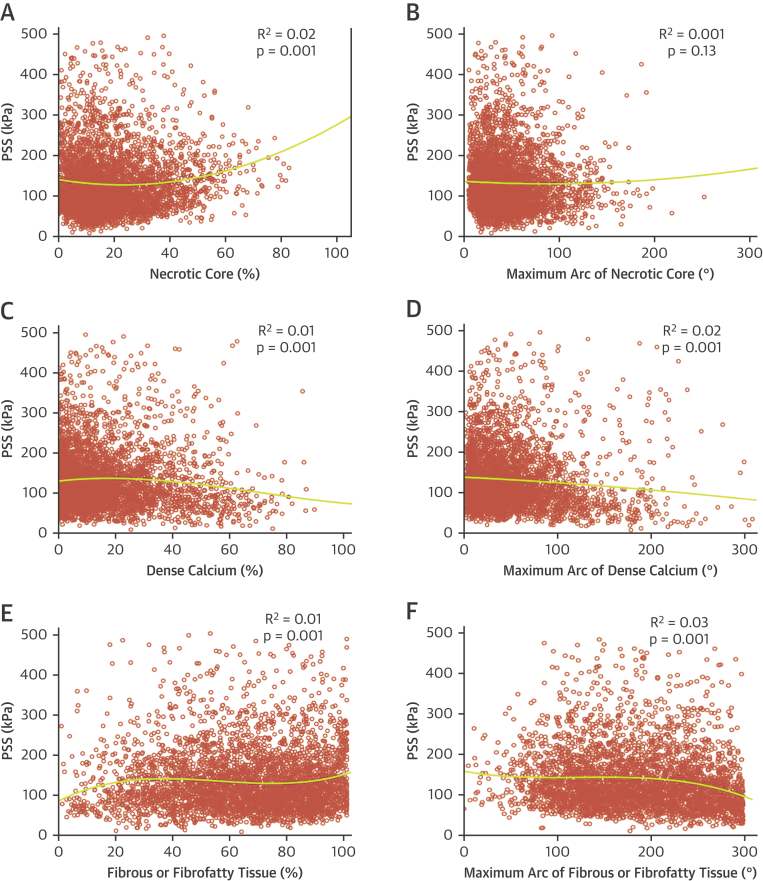
Effect of Plaque Components on PSSRegression curves illustrating best-fit relationships between PSS and (A) necrotic core (%), (B) maximal arc of necrotic core (°), (C) dense calcium (%), (D) maximal arc of dense calcium (°), (E) fibrous/fibrofatty tissue (%), and (F) maximal arc of fibrous/fibrofatty tissue (°). Abbreviation as in Figure 4.